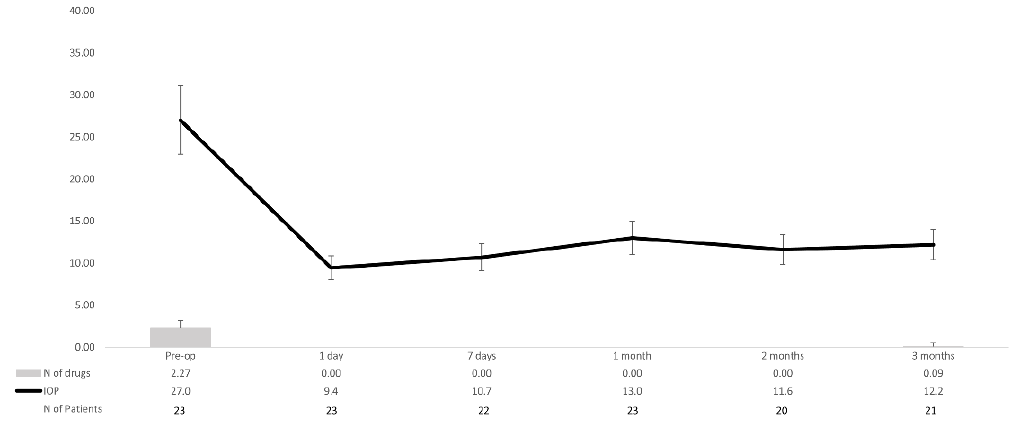
Figure 3. Overview of the mean intraocular pressure (IOP) and number of hypotensive medications over the course of the study follow-up in the overall study population. Vertical bars represent standard deviation. IOP: Intraocular pressure. When compared to baseline, mean (95% confidence interval) IOP lowering was − 17.6